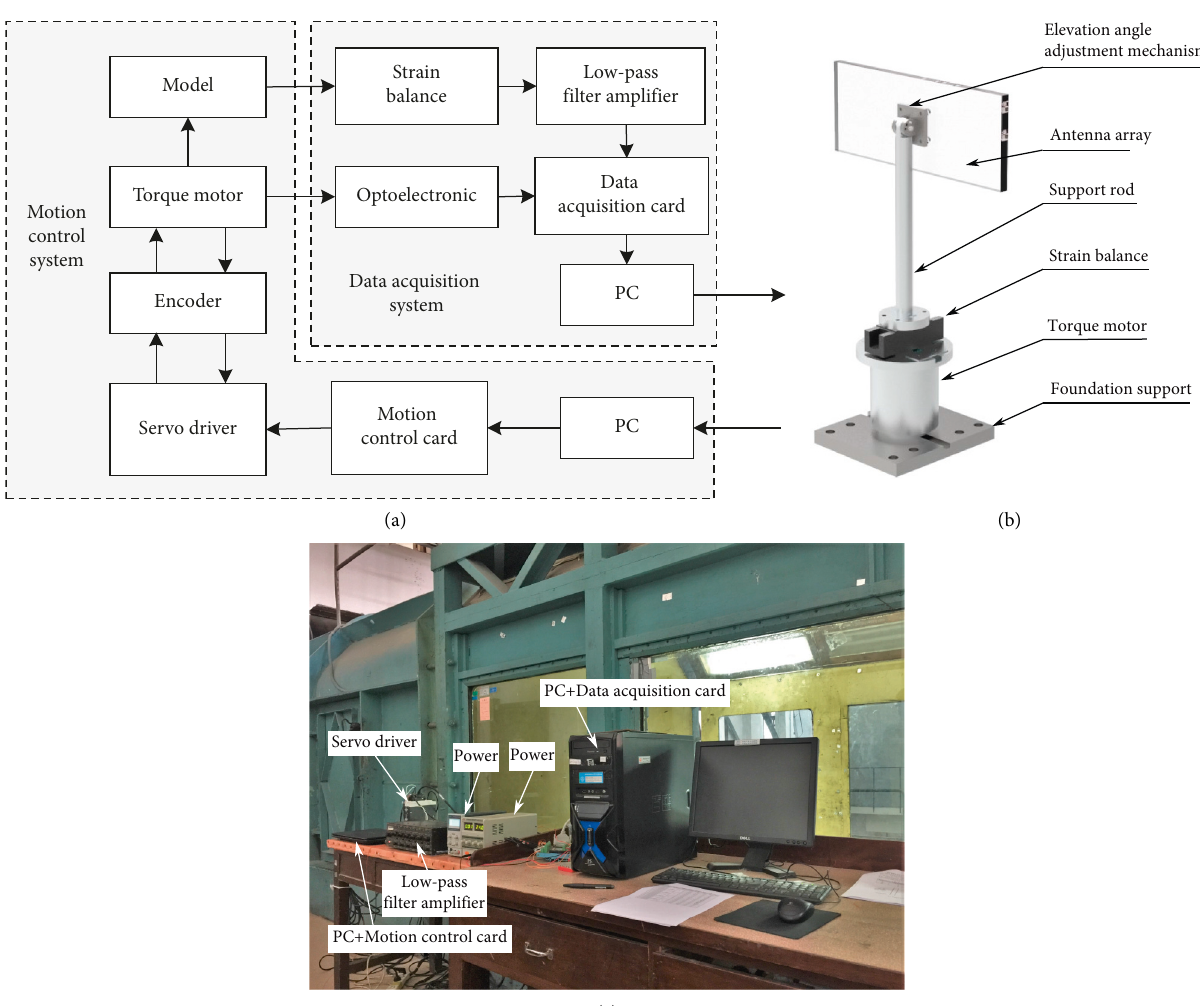
Figure 2: Connection diagram of test device and equipment: (a) schematic diagram of the motion control system and data acquisition system, (b) motion control system, and (c) data acquisition